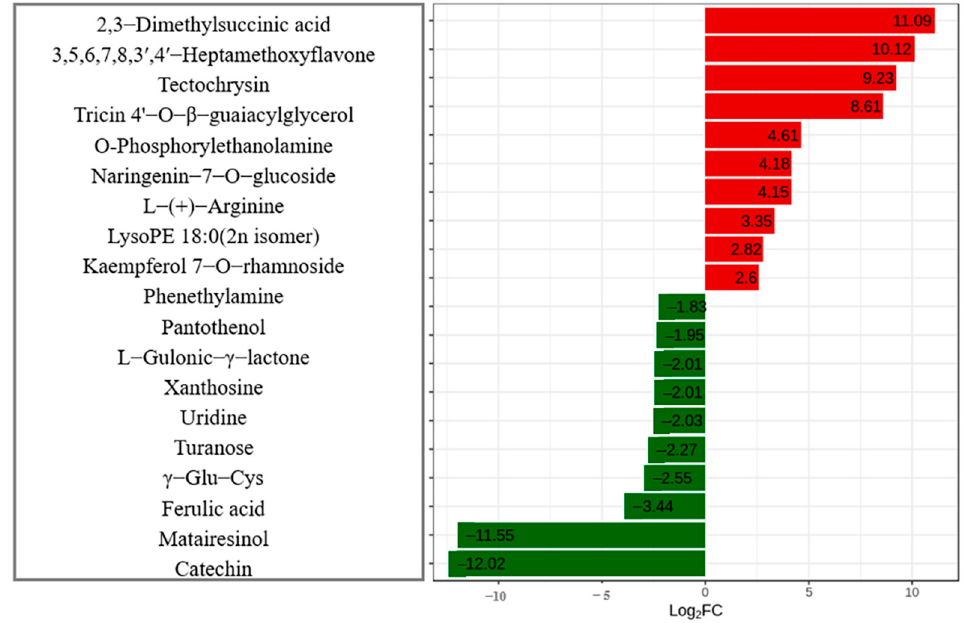
Figure 4. Differential metabolites bar chart of water dropwort under soil culture (CK) and Yamasaki nutrient solution (NK). Red represents up − regulated di ff erentially expressed metabolites and green represents down − regulated di ff erentially expressed metabolites.